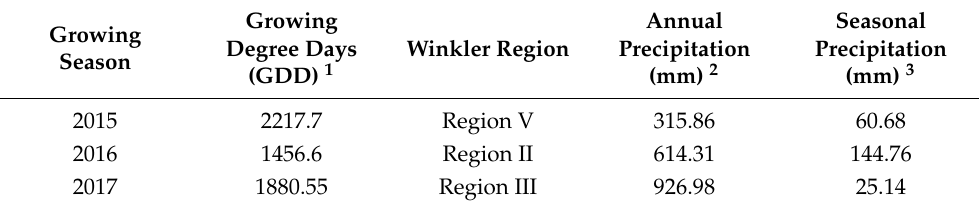
Table 1. Growing degree days (GDD); Winkler region classification; and precipitation for Oakville, California (USA) CIMIS station 77 for 2015, 2016, and 2017. Intermittent missing climate data from